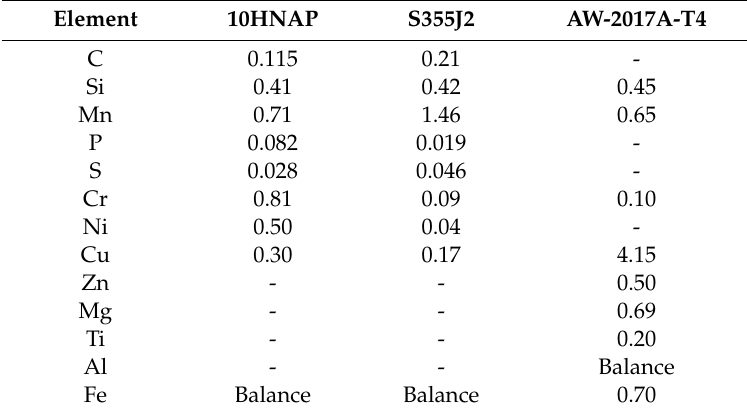
Table 1. Chemical composition of the tested alloys (wt.%)